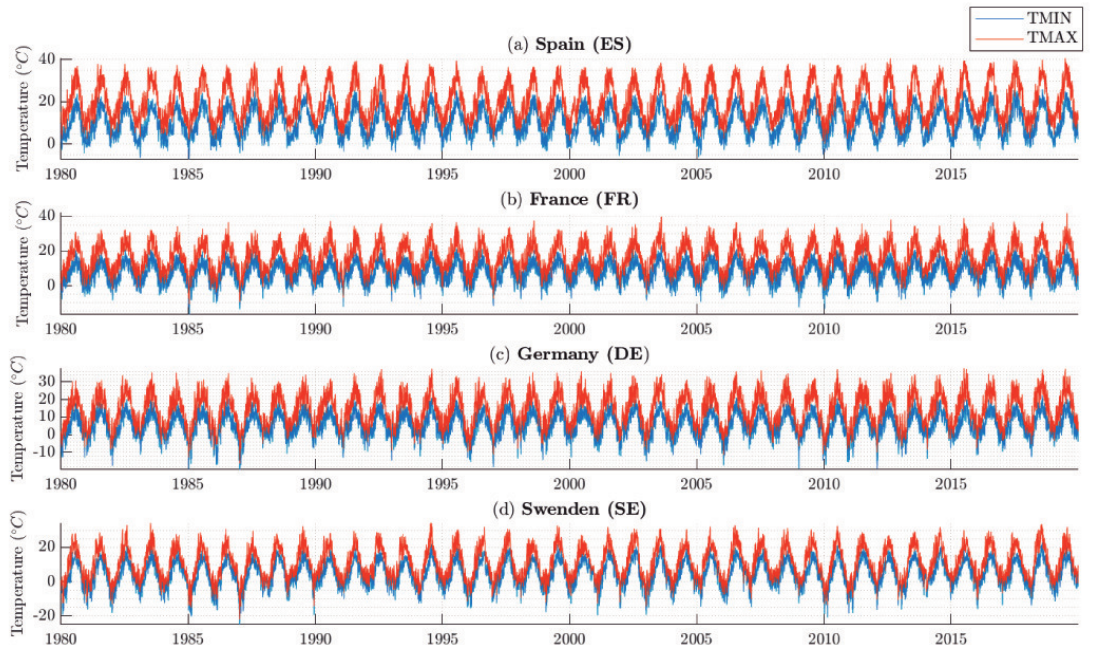
Figure 1. Minimum and maximum daily temperatures of four weather stations from Europe: ( a ) Spain (ES). ( b ) France (FR). ( c ) Germany (DE). ( d ) Sweden